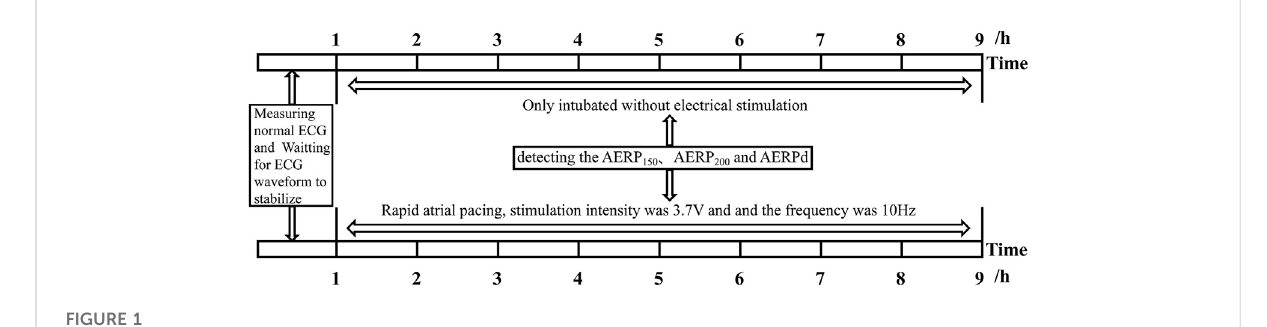
FIGURE 1 Experimental protocols in vivo of rabbit.